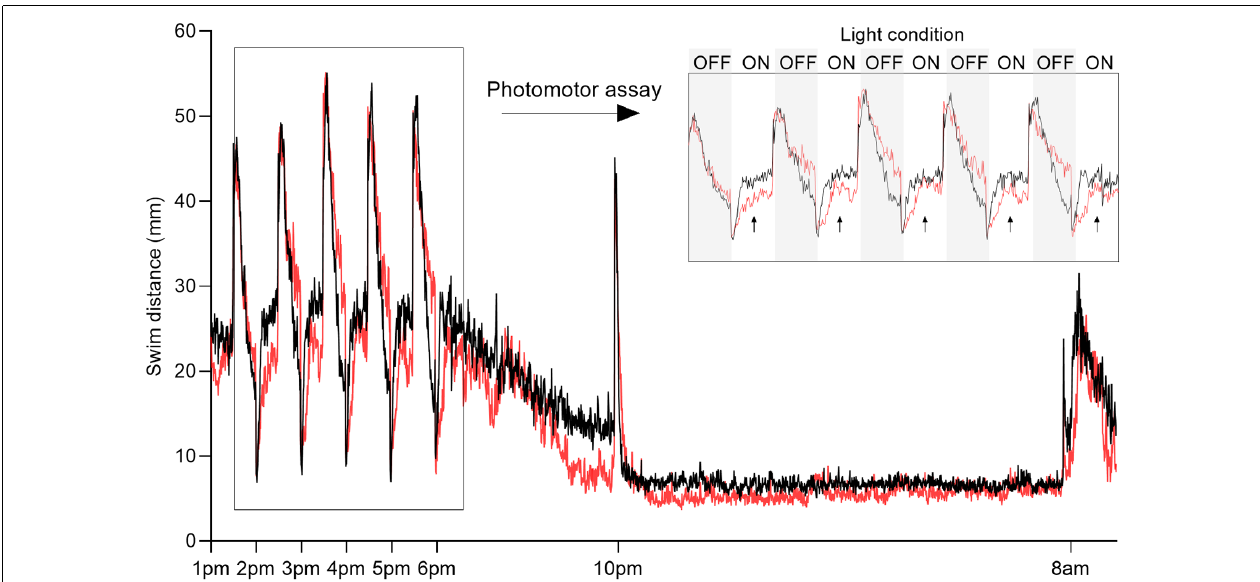
FIGURE 1 | Overview of behavioral recording. Representative plot of swim distance of larvae exposed to 500 µ M 1-methyl-4-phenylpyridinium (MPP+; red) vs. control (black). Inset (top right) shows the swim distance during photomotor assay measured between 1:00 pm and 6:00 pm consisting of five 30-min intervals alternating dark (OFF, gray boxes) and light (ON, white boxes). Arrows indicate the lights-on phases used for analysis. Sleep parameters were evaluated after the transition to darkness from 10:00 pm to 8:00 am the following day.